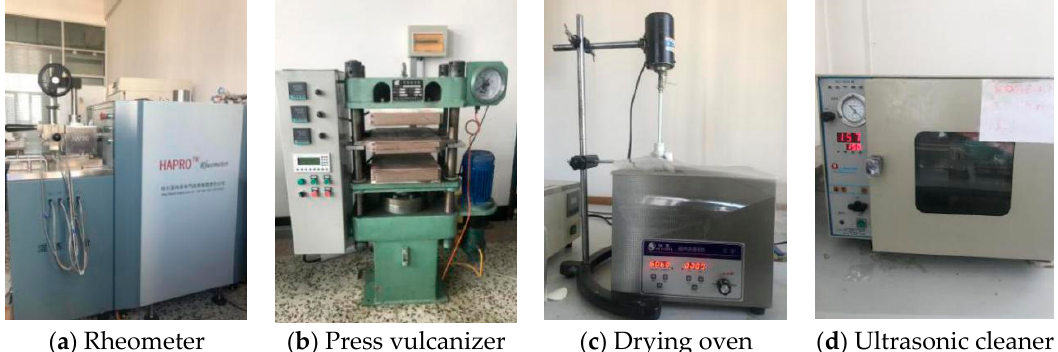
Figure 1. Main experimental equipment.